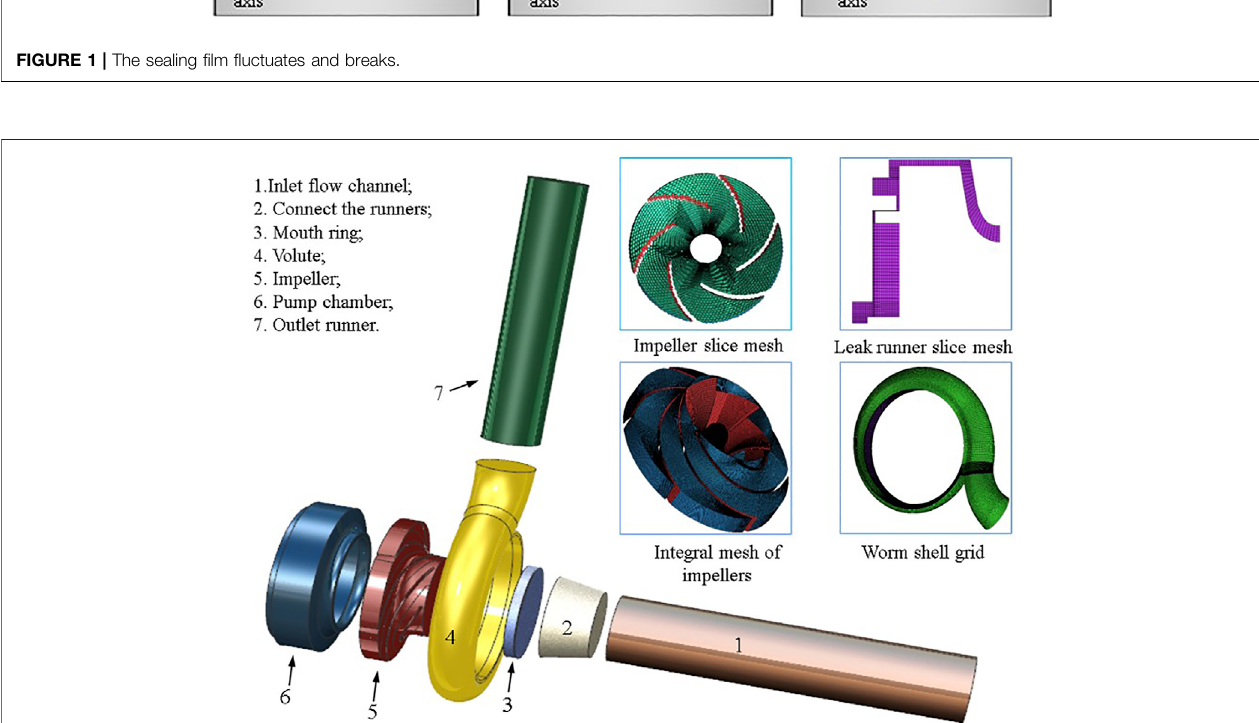
FIGURE 2 | Centrifugal pump model and partial grid